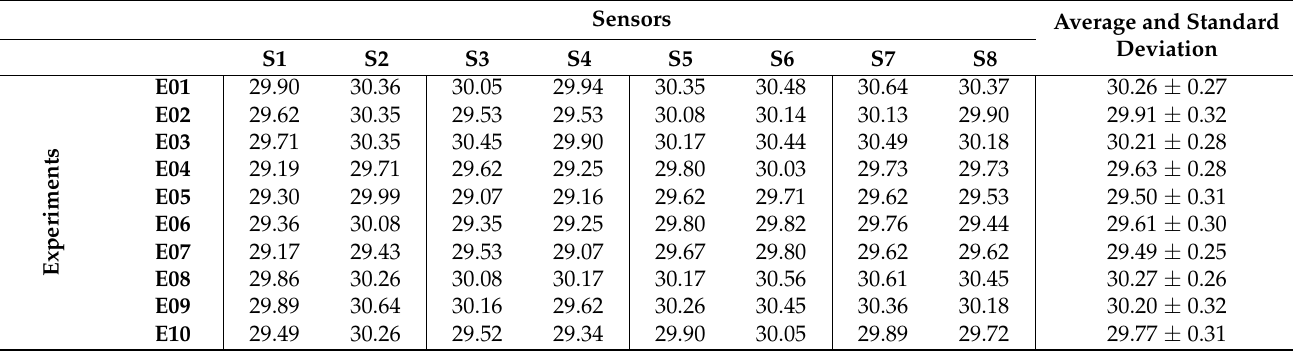
Table 4. Temperatures (in ◦ C) recorded by the NTC sensors (S1–S8) at the same moment of